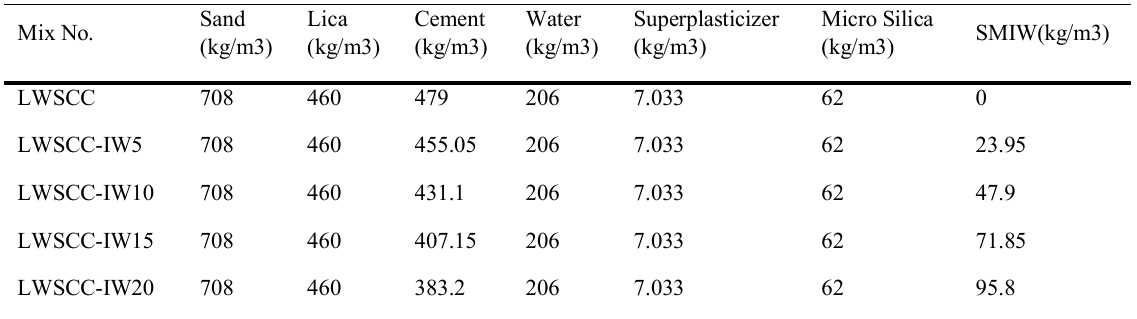
Table 2 . Mix proportions for